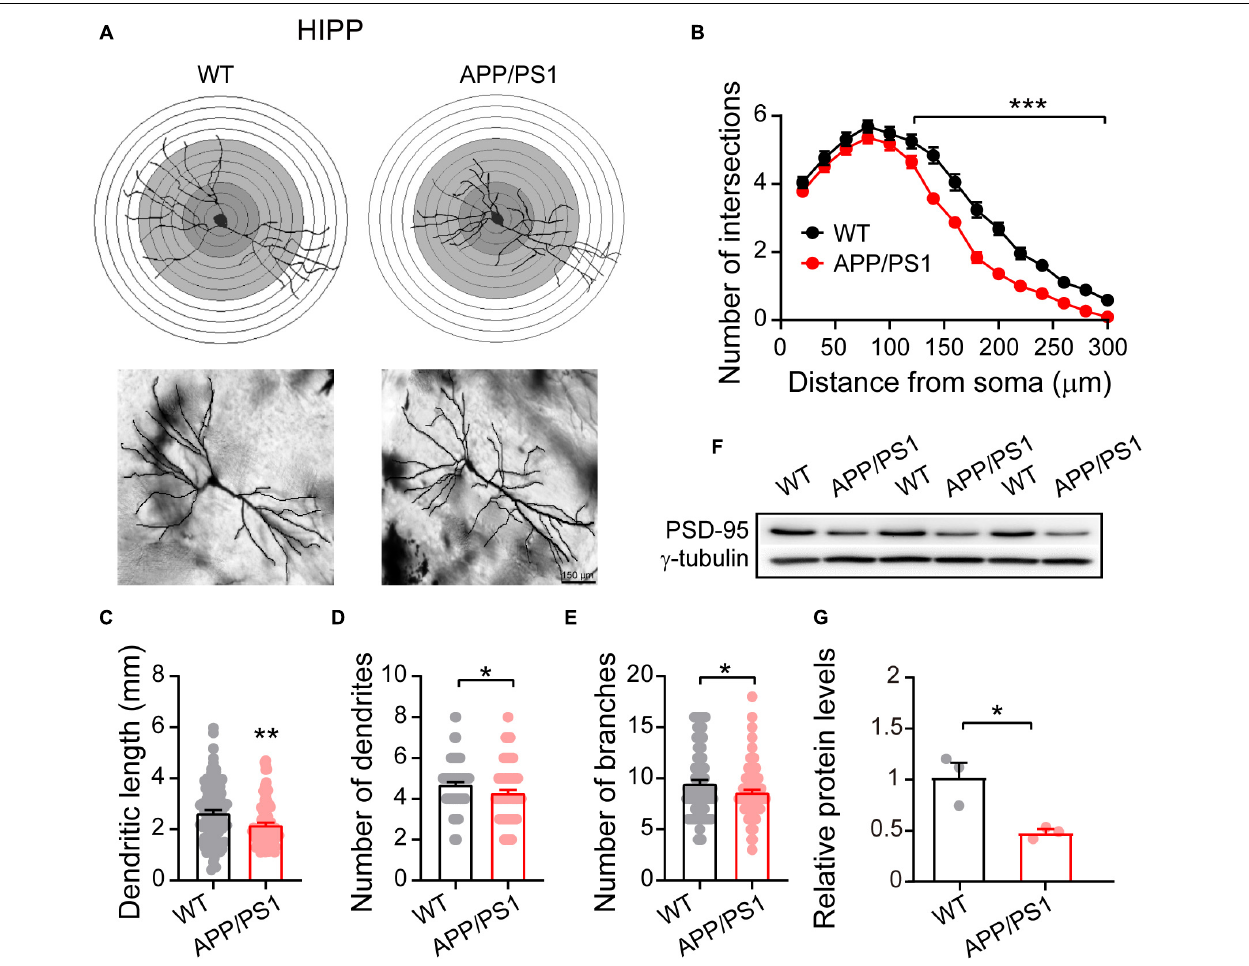
FIGURE 3 | Altered dendritic morphology and decreased PSD-95 levels in the HIPP of 4 ∼ 5-month-old APP/PS1 mice. (A) Schematic photomicrographs of neurons with the allocation of dendrites between repeated 20 µ m-spaced concentric rings. (B) APP/PS1 mice exhibit a reduced number of intersection points compared with age-matched WT (at a distance of 120–300 µ m from the soma). (C–E) The dendrite length, number and branches of hippocampal neurons are significantly decreased in APP/PS1 mice compared with age-matched WT animals ( n = 100 neurons from 4 animals per genotype; one-way ANOVA). (F) Representative immunoblotting images of HIPP extracts and (G) quantification of blots indicate significantly decreased levels of PSD-95 in APP/PS1 mice compared with age-matched WT mice ( n = 3 mice per genotype; two-sample t -test). Each value represents the mean ± SEM; * p < 0.05, ** p < 0.01, *** p < 0.001.